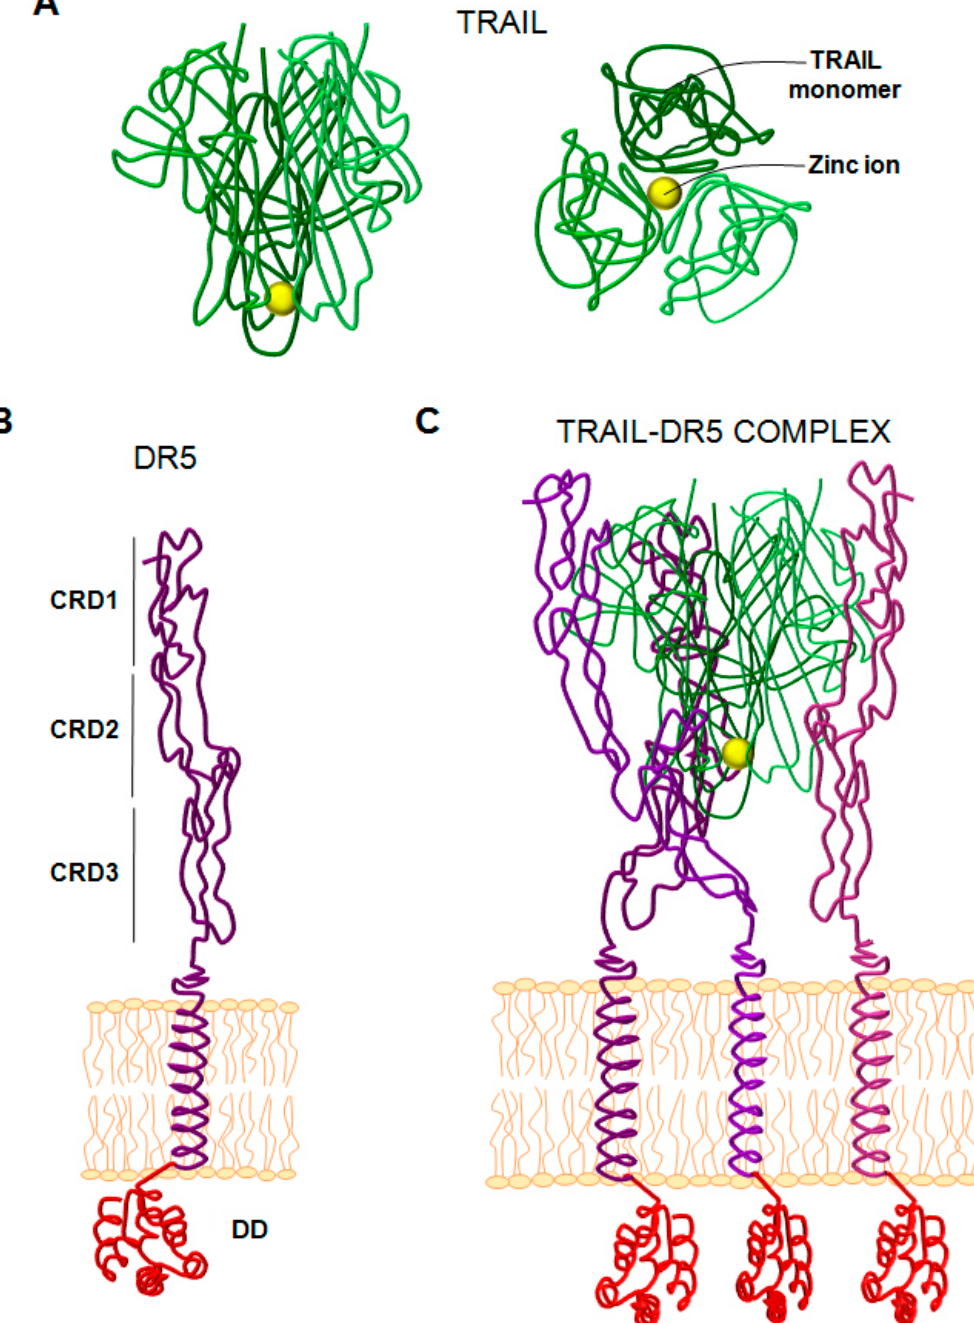
Figure 1. Structure of (TNF)-related apoptosis-inducing ligand (TRAIL) and DR5. ( A ) Structure of the TRAIL trimer. Left panel corresponds to the side view and right panel to the down view. Yellow sphere corresponds to a Zinc ion. ( B ) Structure of the DR5 (TRAIL-R2) monomer anchored to cell surface. CRD (cystein rich domain). DD (death domain). ( C ) TRAIL-DR5 complex. The TRAIL trimer is drawn as tubes rendering in gradations of green, and the three receptor molecules are rendered as tubes in gradations of purple.